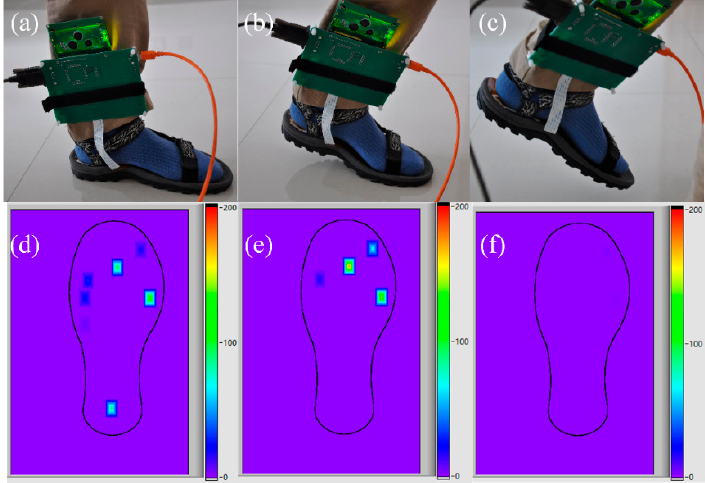
Figure 10. ( a ) Picture of the foot flat; ( b ) picture of the heel off; ( c ) picture of the midswing; ( d ) plantar pressure of the foot flat; ( e ) plantar pressure of the heel off; ( f ) plantar pressure of the midswing.